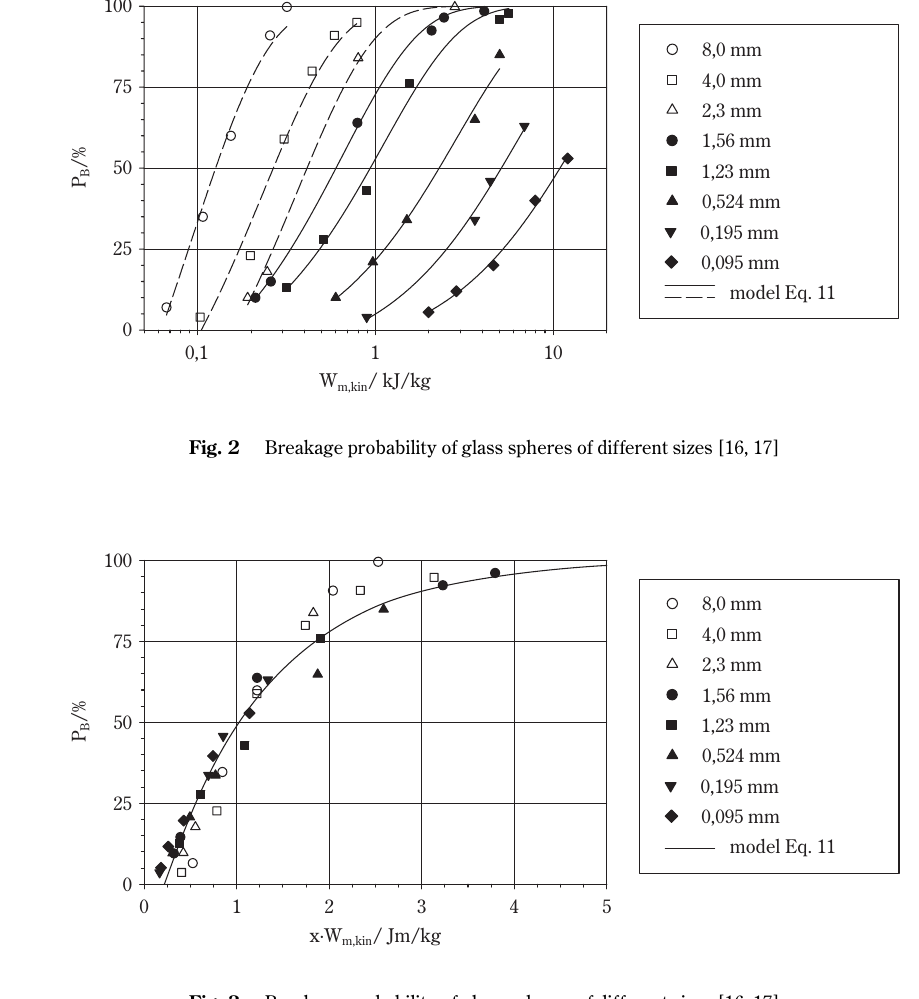
Fig. 3 Breakage probability of glass spheres of different sizes [16,